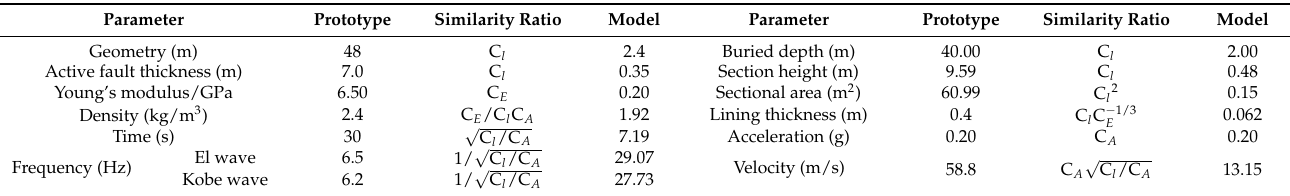
Table 1. Similarity ratios of the tunnel and surrounding rock.